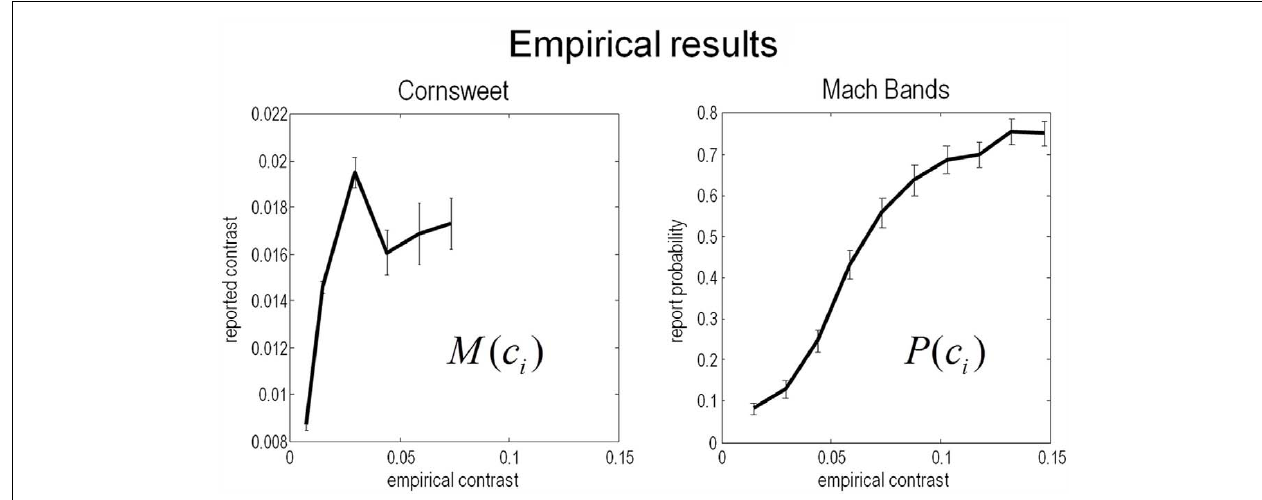
quantified in terms of probability that the illusion is reported to be present. Both results are shown as functions of empirical (Weber) stimulus contrast levels.We have used the same range for both graphs so that the dependency on contrast levels can be compared.The key thing to note here is that the Cornsweet illusion peaks before the Mach band illusion (vertical